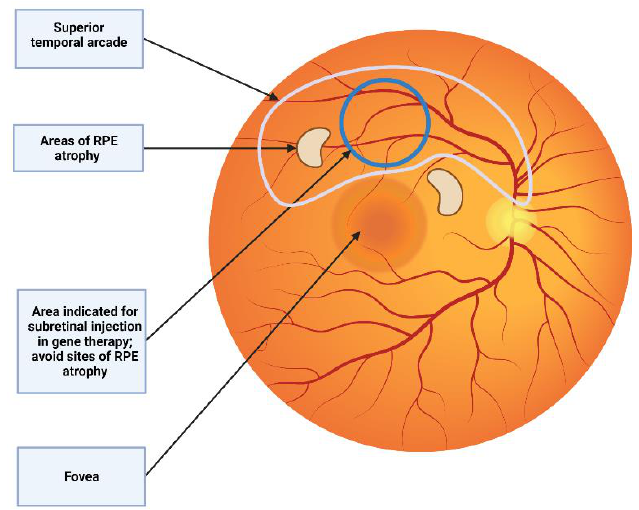
Figure 5. Subretinal injection location. The superior vascular arcade is the preferred location for subretinal injection. It is recommended to avoid areas of RPE atrophy where the retina is more pre- disposed to